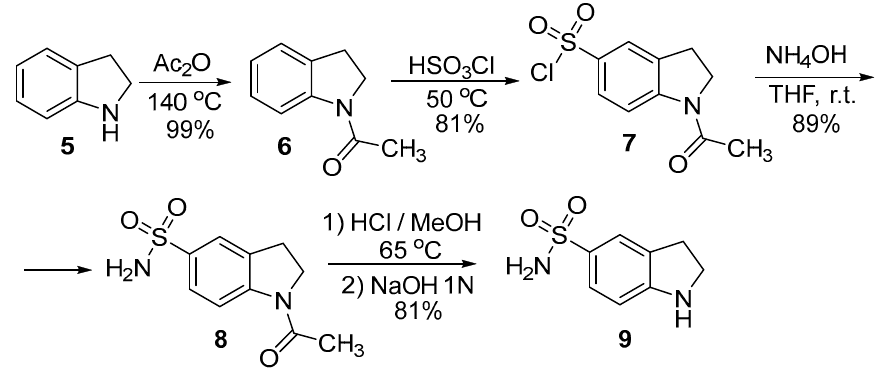
Figure 3. Modelling of aminoindanesulfoamide 3 (blue) and indoline analog 4e (purple) in the active site of CA IX (PDB 5sz5).